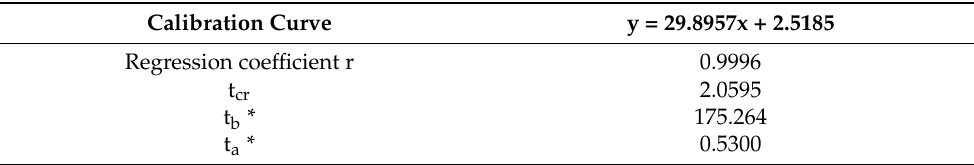
Table 1. The values of parameters calculated on the basis of the calibration curve to determine the linearity of the voltammetric method.